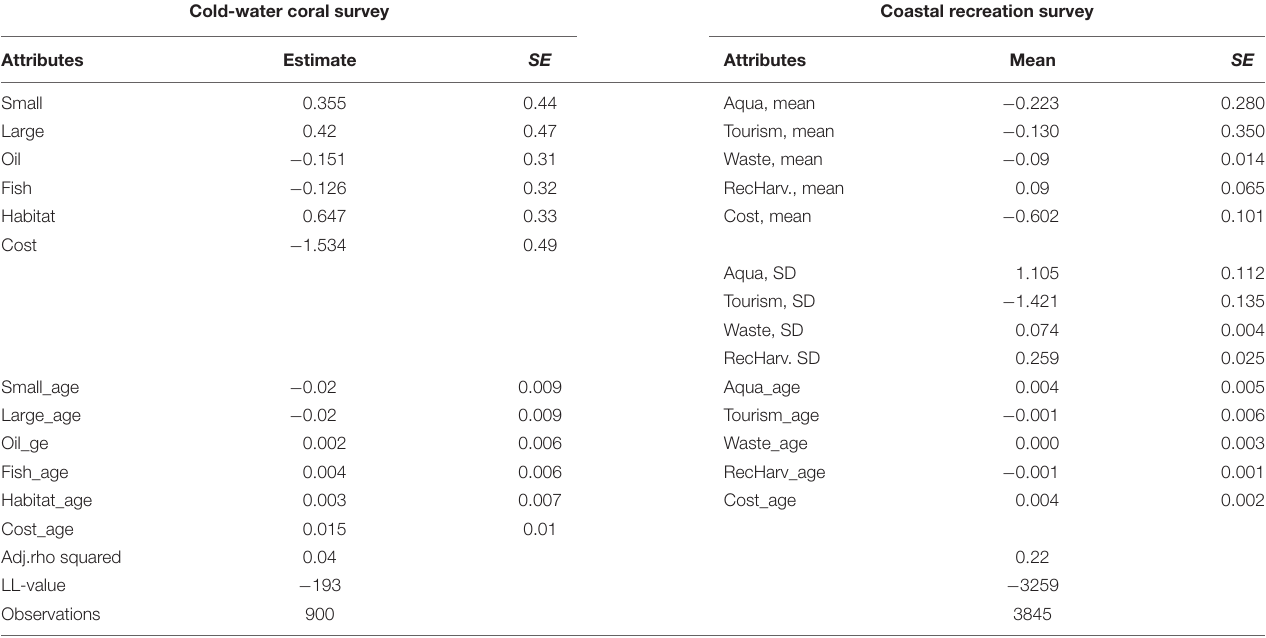
TABLE A4 | Results for model with socio-demographic interaction for age. Cold-water coral survey Coastal recreation survey